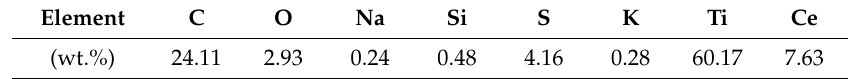
Figure 1. TEM images of Ce x Ti y O z nanocontainers loaded with ATT. Table 2. Tabulated values of the EDS analysis of the Ce x Ti y O z nanocontainers loaded with